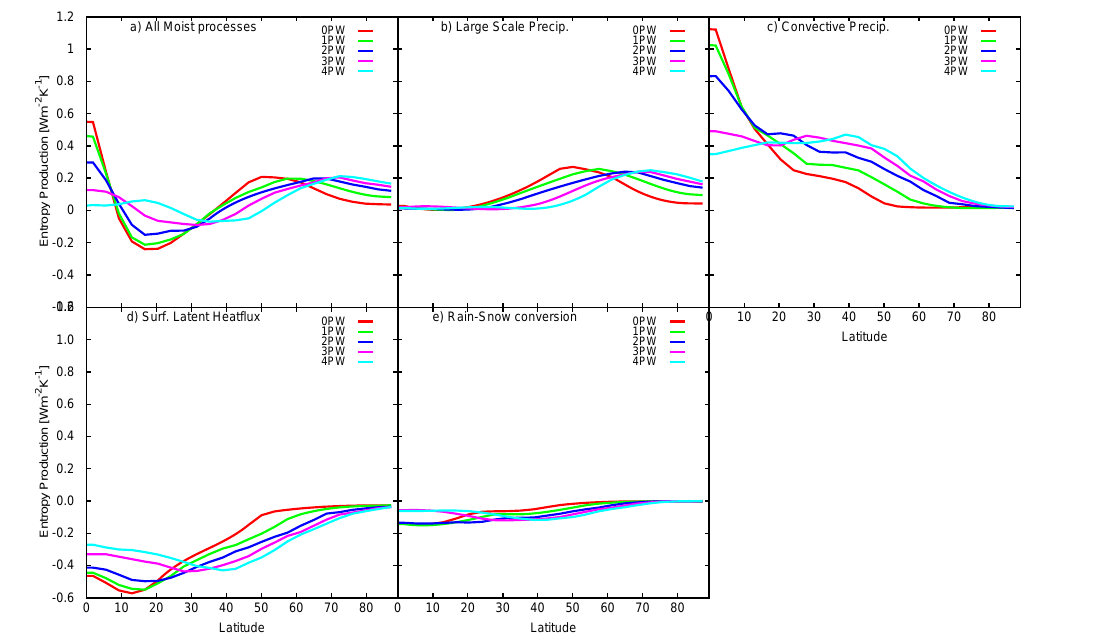
Figure 10. Entropy production from moist processes for OHT max = 0, 1, 2, 3, and 4PW.